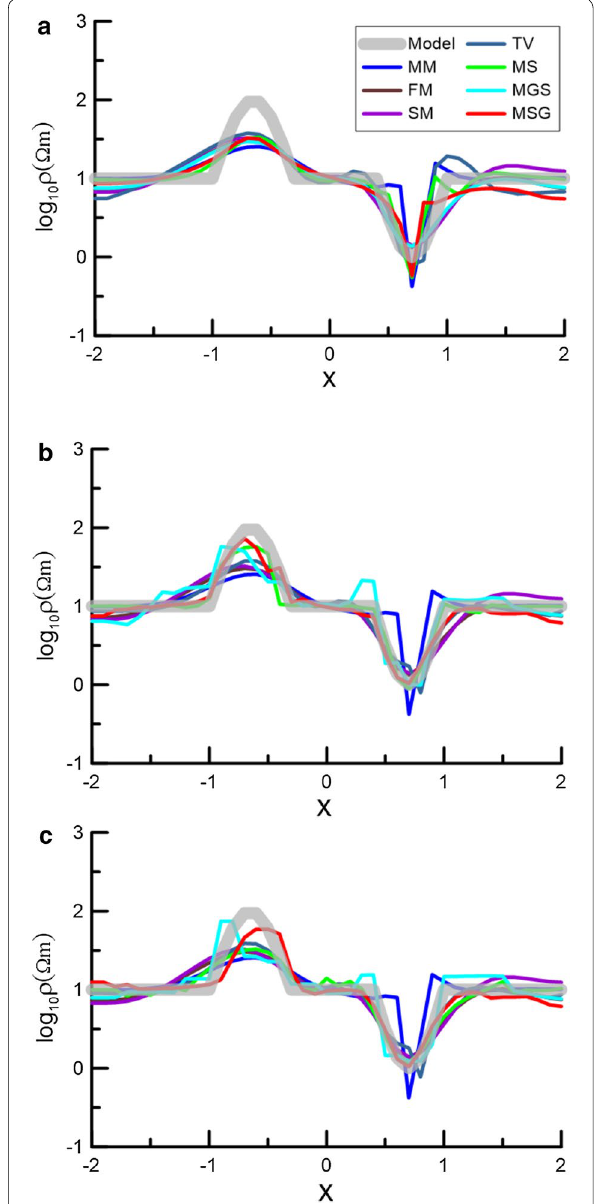
Fig. 6 1D smooth boundary model inversion results with different stabilizing functionals. Inversion results with β 2 of a 0.1, b 0.001, and c